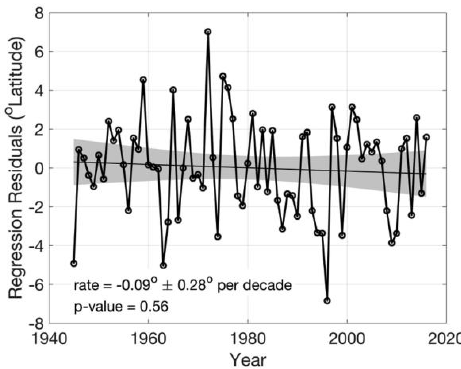
Figure 4. Similar to Figure 1, but for the residuals of the regression of annual-mean latitude of North Atlantic peak TC intensity onto an AMO index.